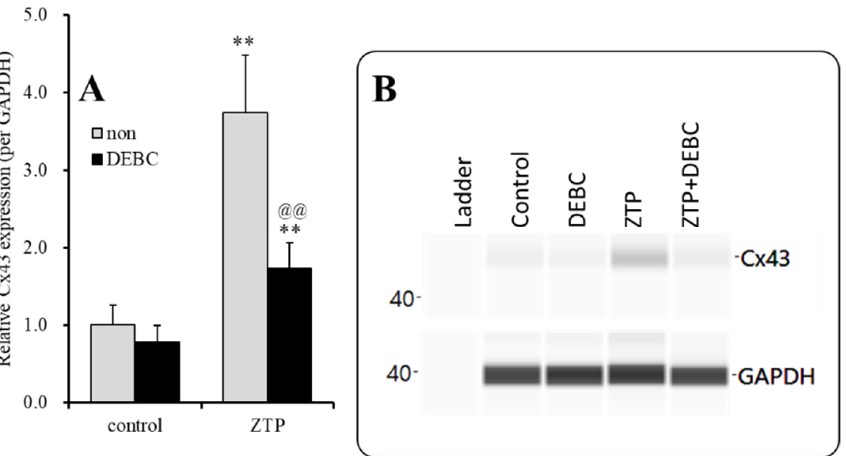
Figure 6. Interaction between subchronic administration of supratherapeutic concentration of ZTP and Akt inhibitor (DEBC) on Cx43 protein expression in the astroglial plasma membrane fraction ( A ) and their pseudogel images, using capillary immunoblotting ( B ). Ordinate: mean ± SD (n = 6) of the relative protein level of Cx43 (per GAPDH). Effects of ZTP (1000 nM) and Akt inhibitor (DEBC: 10 μ M) on Cx43 expression in the plasma membrane fraction of the primary cultured astrocytes were analysed by two-way ANOVA with Tukey’s (wholly significant difference) post hoc test (** p < 0.01 vs. control, @@ p < 0.01 vs. non).